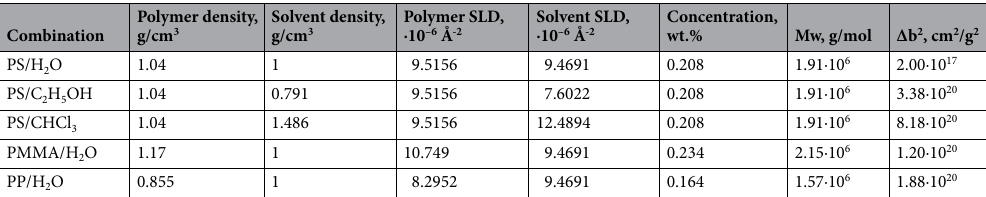
Table 1. Overview of the parameters for the two-phase systems used in simulations.